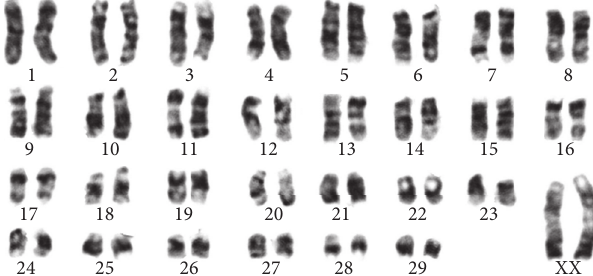
Figure 4: Karyotype of endometrial mesenchymal stromal stem cells in passage 4 of cyclic